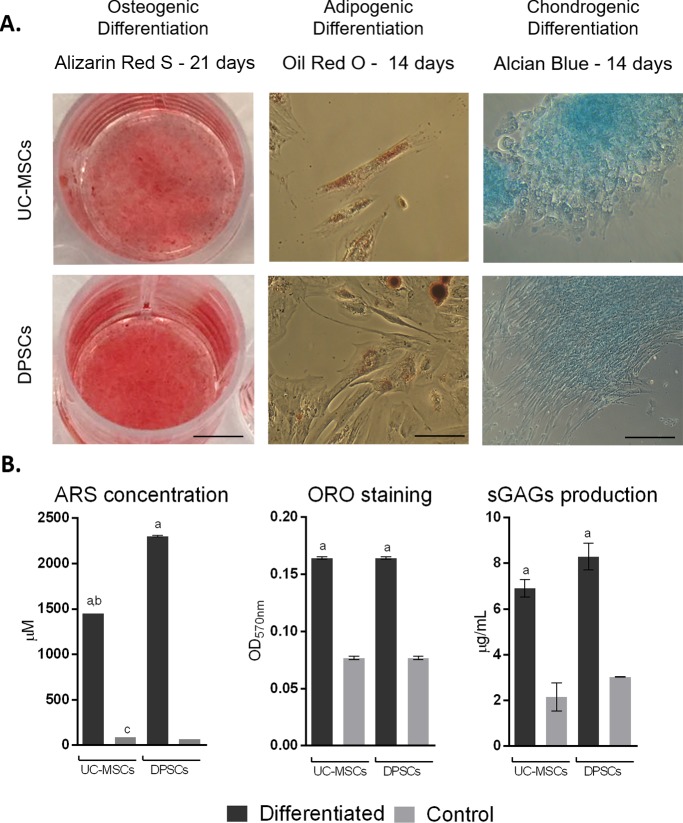
Multilineage differentiation.A) Qualitative evaluation—Osteogenic differentiation: Alizarin Red S (ARS) staining after 21 days (scale bar = 6000 μm); Adipogenic differentiation: Oil Red O (ORO) staining after 14 days (scale bar = 100 μm); Chondrogenic differentiation: Alcian blue staining after 14 days (scale bar = 400 μm). B) Semi-Quantitative evaluation—Osteogenic differentiation: ARS concentration (μM) after 21 days; Adipogenic differentiation: Oil Red O (OD570nm) after 14 days; and C) Chondrogenic differentiation: Sulfated GAGs production (μg/ml) after 14 days, assessed by Blyscan™ Glycosaminoglycan Assay (Biocolor, UK). Control: Undifferentiated control; Results presented as Mean ± SEM. a: significantly different from undifferentiated group; b: UC-MSCs differentiated group significantly different from DPSCs differentiated group; c: UC-MSCs undifferentiated group significantly different from DPSCs undifferentiated group (P<0.05).